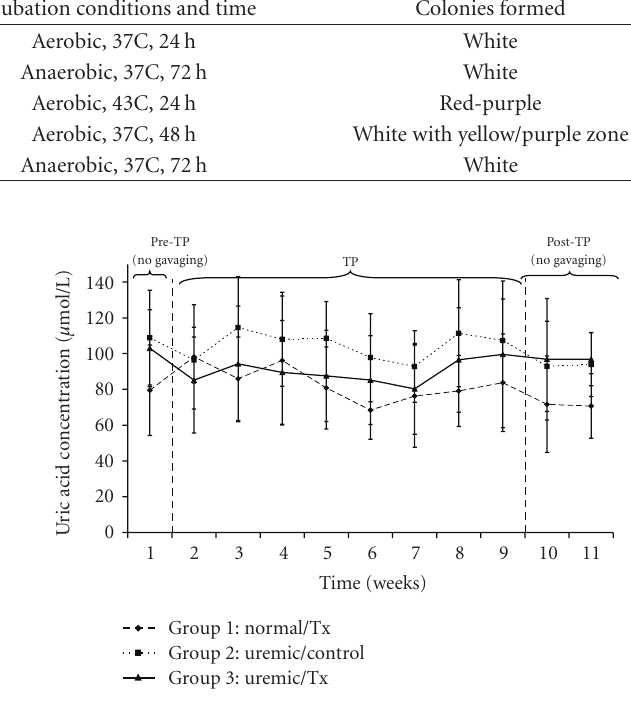
Figure 4: Plasma uric acid concentration before, during and after oral administration of APA microencapsulated yeast cells.